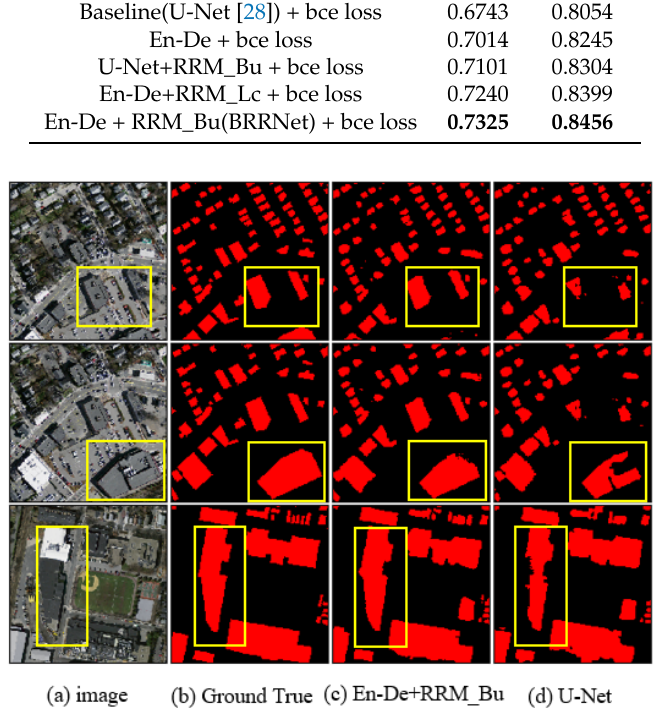
Figure 5. Typical results of the baseline U-Net and our network BRRNet, which is the combination of En-De and RRM_Bu. We used BCE loss as the loss function in these experiments: ( a ) input image; ( b ) ground truth; ( c ) the results of our network BRRNet; and ( d ) the results of the baseline U-Net. The areas in the yellow boxes are the more obvious